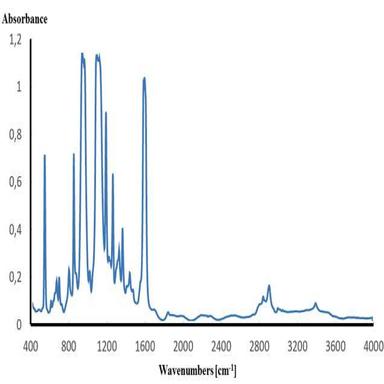
The FTIR spectrum of so-called metallised fibre from sample 30.